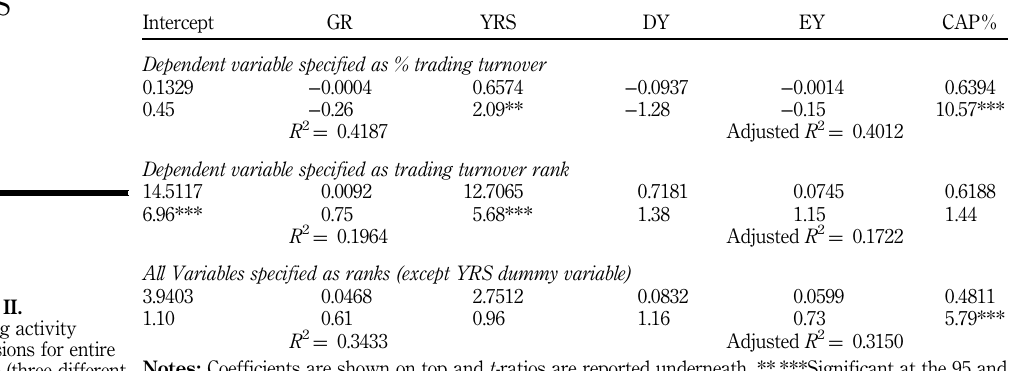
Table II. Trading activity regressions for entire sample (three different versions)